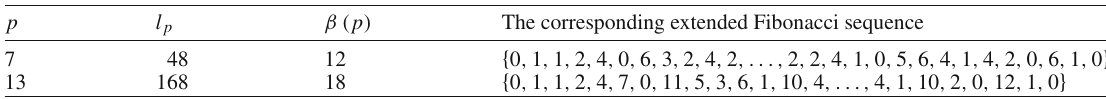
Table 5 Extended Fibonacci sequences computed in F 7 and F